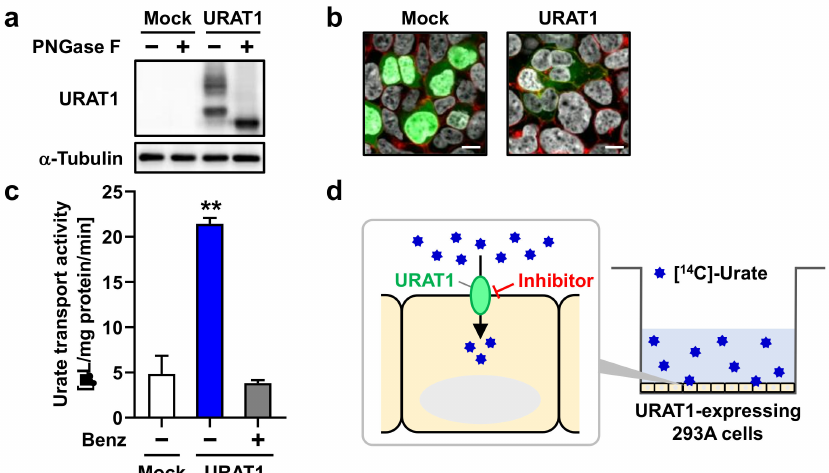
Figure 1. Cell-based urate transport assay with 293A cells transiently expressing URAT1. ( a ) Immunoblot detection of URAT1 protein in whole-cell lysates prepared 48 h after the transfection. α